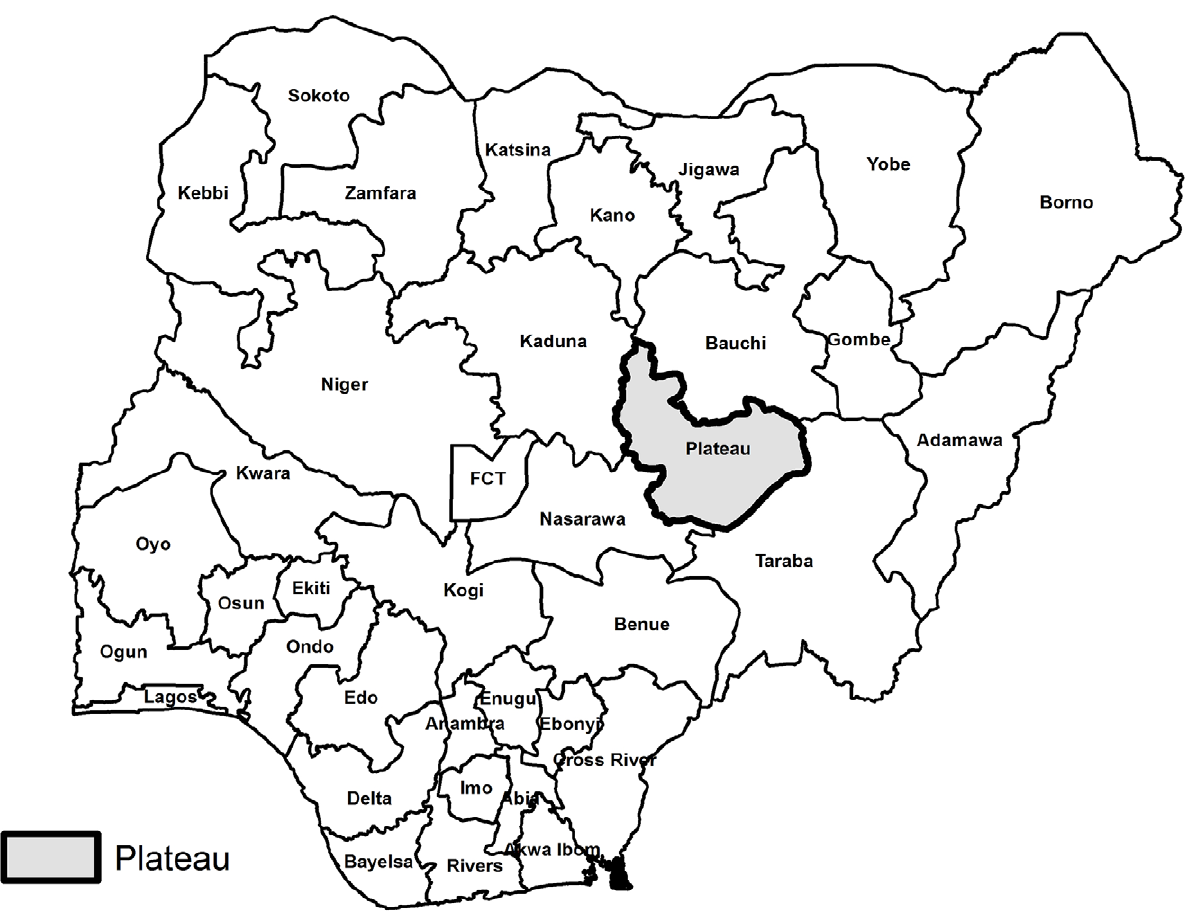
Figure 1. Location of Plateau State, Nigeria.